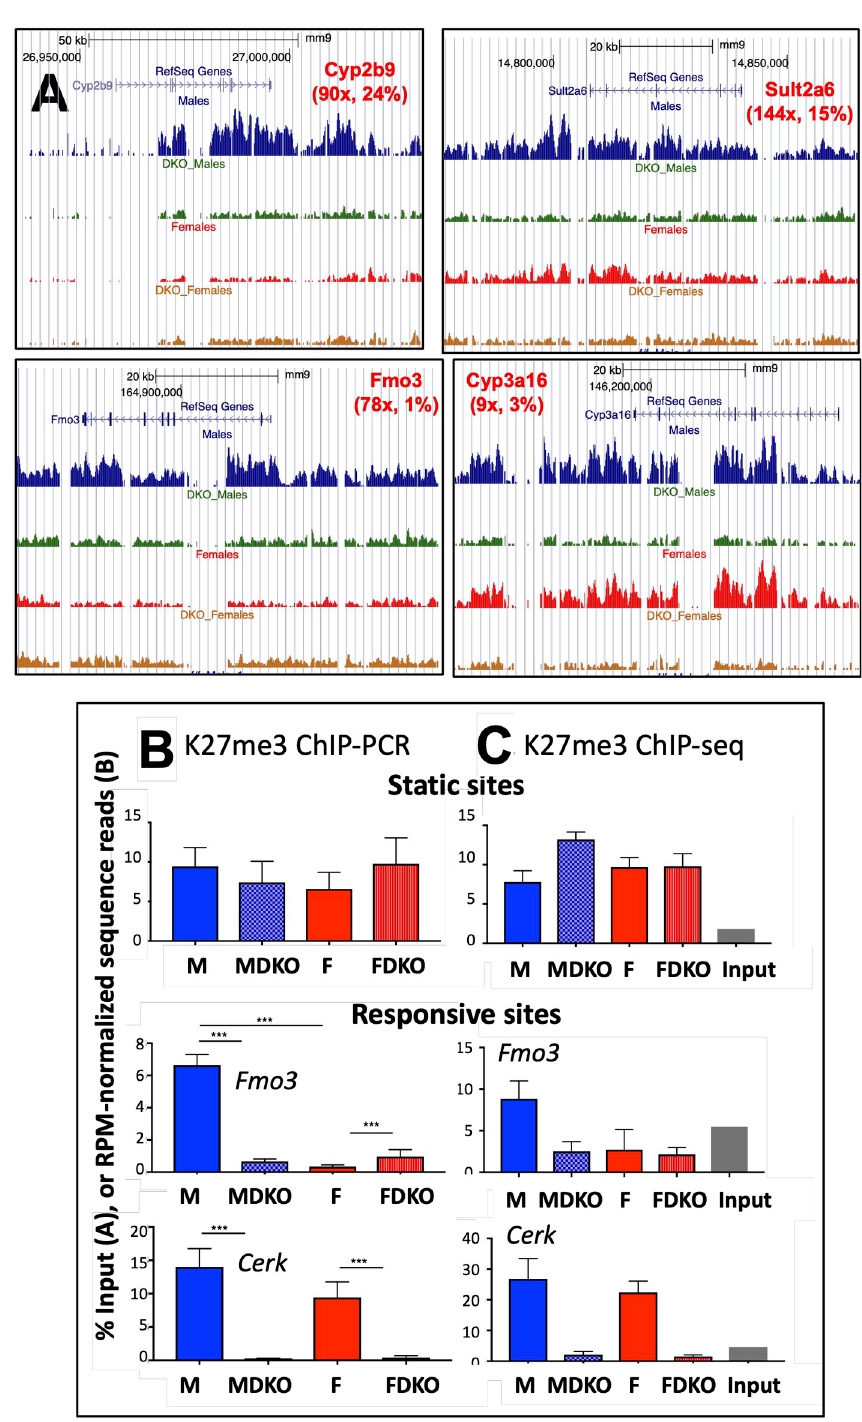
Fig 4. Normalization of H3K27me3 ChIP-seq datasets. ( A ) UCSC Browser screenshots showing loss of H3K27me3 sequence reads across the gene bodies of four female-biased genes. The male-bias in H3K27me3 read density in control liver (first vs. third track) but not in E1/E2-KO liver (DKO; second vs. fourth track) is also apparent. Values shown in parenthesis are: female to male expression ratio in wild-type mouse liver, and the percent feminization of gene expression in male E1/E2-KO liver (see data in S3 Fig). ( B ) ChIP-qPCR validation, and ( C ) reads per million (RPM) normalized read counts at a K27me3 static site (top row) and at two E1/E2-KO-responsive K27me3 differential sites identified by DiffReps (next two rows). The genomic regions interrogated map to a static intergenic region (top